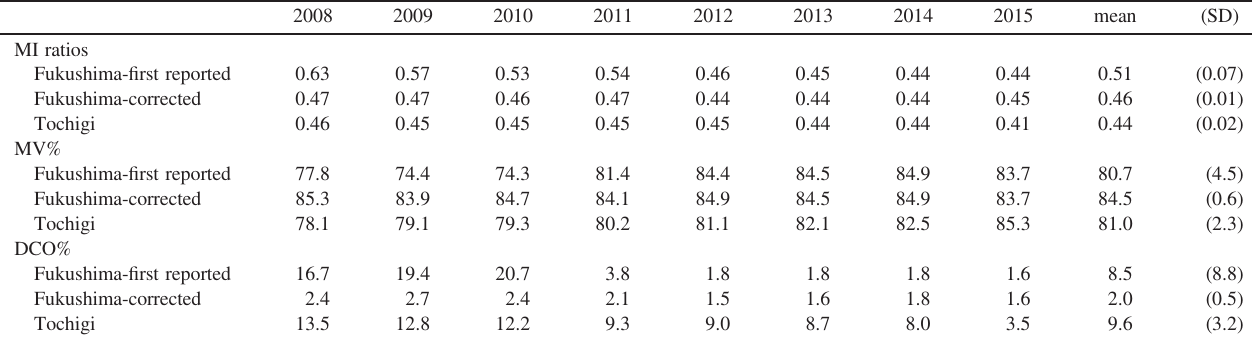
Table 1. MI ratio, MV%, and DCO% from 2008 to